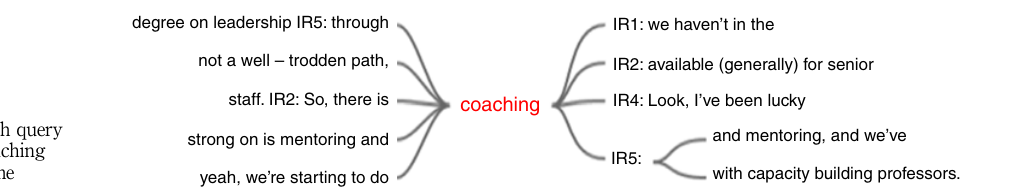
Figure 2. Text search